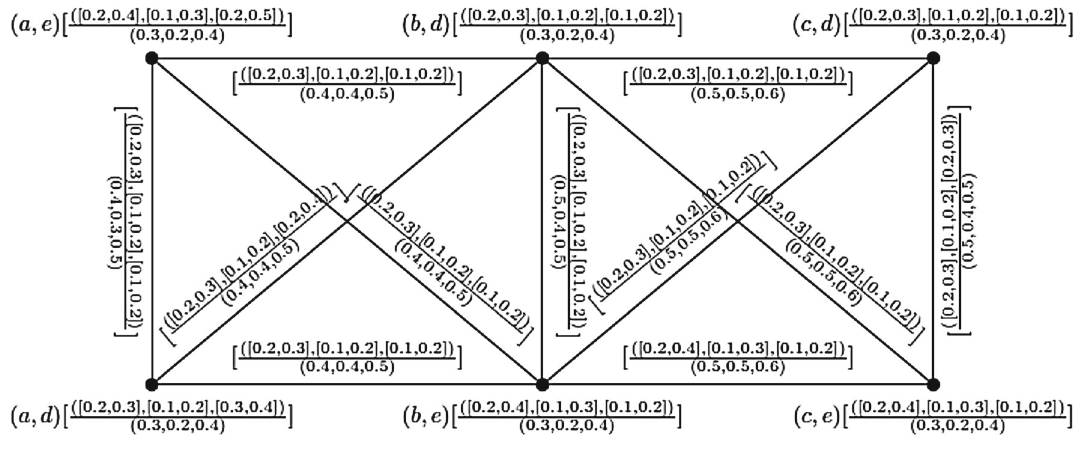
Figure 6: 3pc graph G